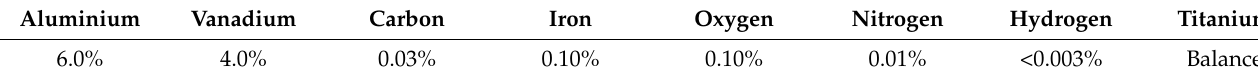
Table 2. Chemical specifications of Arcam Ti6Al4V ELI [33].